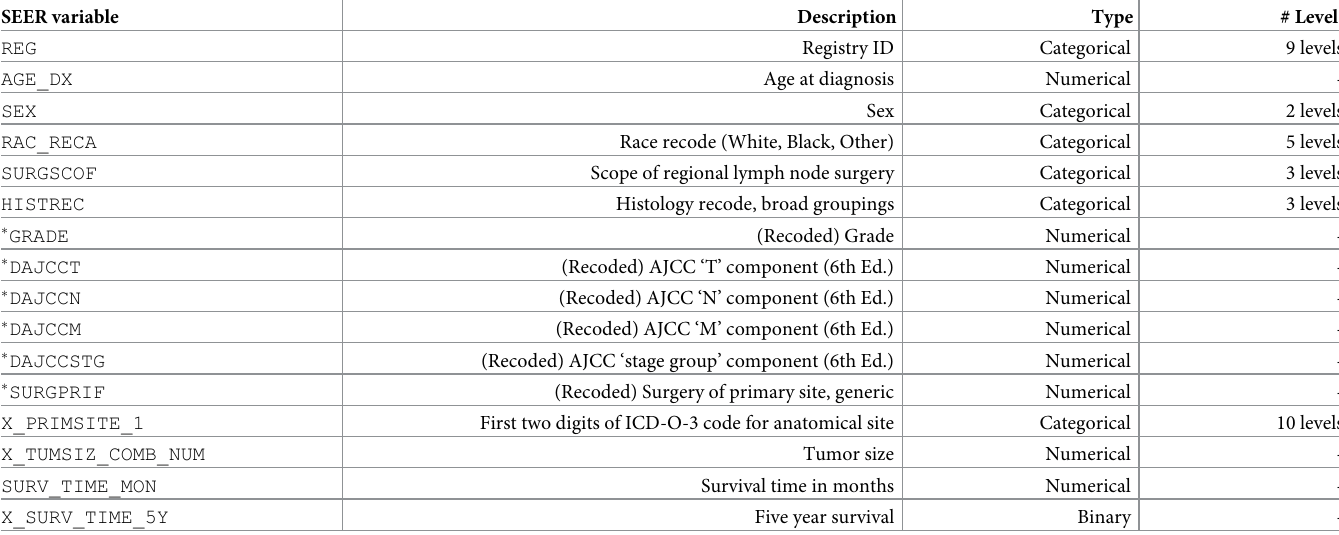
Table 3. Variables obtained from SEER database and used as 5-year survival prediction features.